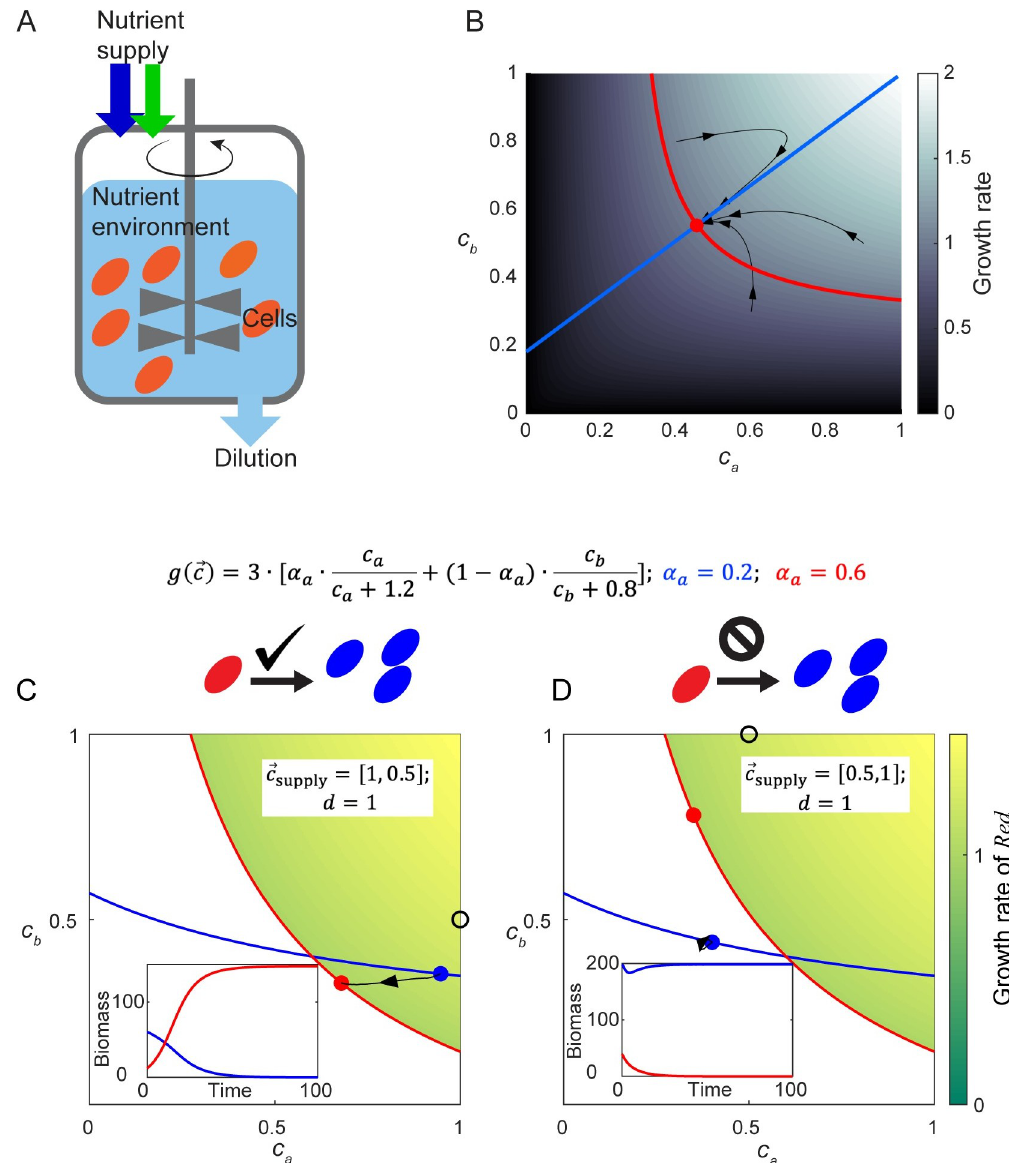
Fig 1. Chemostat behavior represented in chemical space. A. Schematic diagram of a chemostat occupied by a single microbial species. In the well-mixed medium (pale blue) of a chemostat, cells (orange ellipses) consume nutrients and grow. An influx of nutrients with fixed concentrations (blue and green arrows) is supplied at the same rate as dilution, keeping the medium volume constant. B. Visual representation of how a species creates its own chemostat environment. Background color indicates the growth rate of cells as a function of metabolite concentrations c and c , with the growth contour shown by a b the red curve. The flux-balance curve is shown in blue. Black curves with arrows show the time trajectories of chemostat simulation. C. Example of successful invasion of the indigenous species Blue by the invader species Red . A small amount of species Red is introduced to a steady-state chemostat of species Blue . Growth contours and steady-state environments of species Blue and species Red are shown as curves and dots in the corresponding colors (colored background indicates the “invasion zone” of Red , and represents the growth rate of Red in this zone). The supply condition is marked by a black circle. Black curves with arrows show the time trajectory of the invasion in chemical space. Inset: time course of species biomass in the chemostat during the invasion. D. Same as (C), except that because the supply condition (black circle) is different, the attempted invasion by species Red is